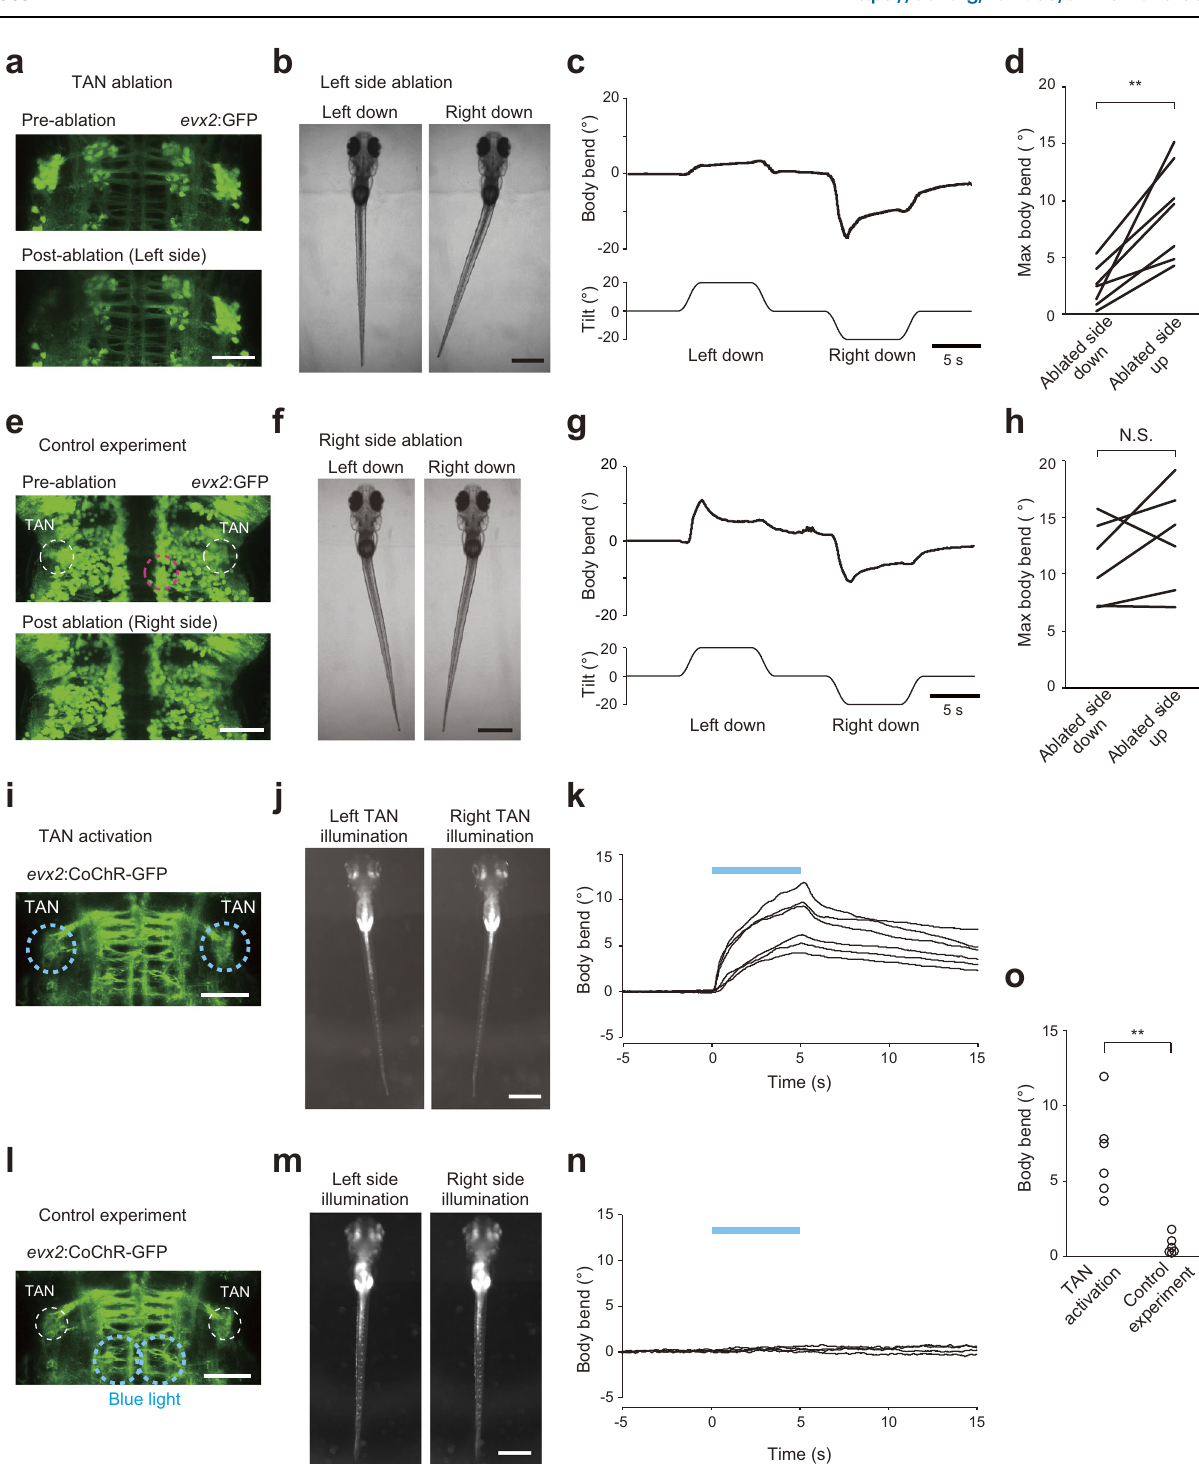
neurons at single-cell resolution using a tiltable objective microscope with a spinning-disk confocal unit 20 . For this purpose, nMLF neurons were retrogradely labeled with a green chemical fl uorescent Ca 2+ indicator, Cal-520 dextran, and a red chemical fl uorescent dye, rho- damine dextran. Figure 6a shows images with a maximum intensity projection and a single optical plane. During the tilt in the ipsi-up direction, a large increase in Δ R/R 0 was observed in subsets of small- sized nMLF neurons (cell #1, #7, and #8 in Fig. 6b). Uniquely identi fi - able large nMLF neurons (MeLr, MeLc, MeLm), however, exhibited little or a relatively low level of Δ R/R 0 increase during the tilt (cell #4,